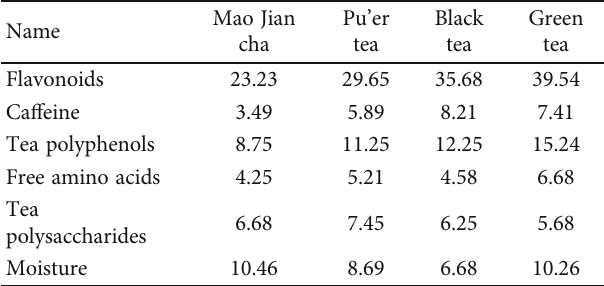
Table 2: Results of the content assay.